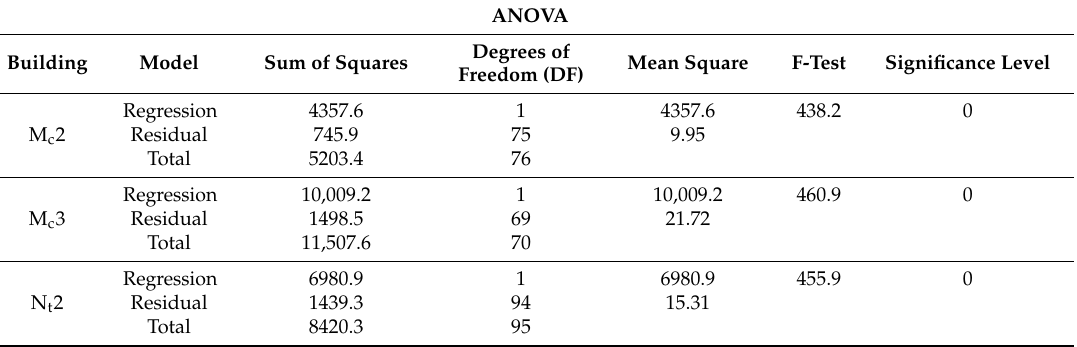
Table 4. Analysis of variance between measured and modelled data for NO 2 .